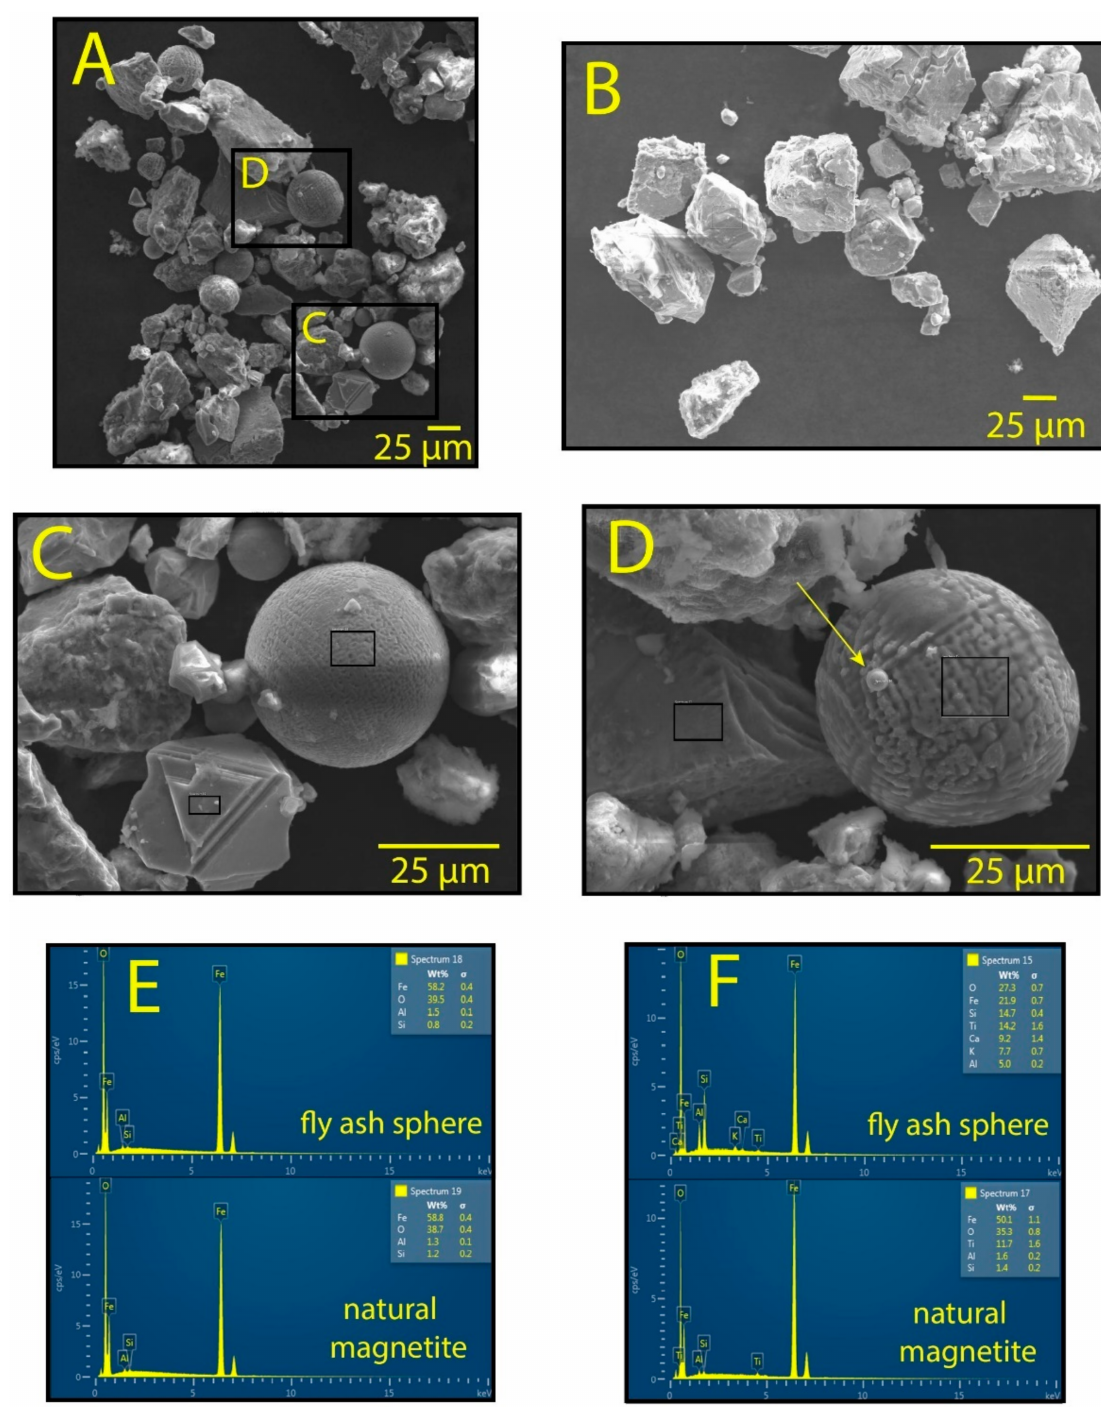
Figure 5. Scanning electron microscope images and energy dispersive X-ray spectroscopy (EDS): ( A ) Multiple fly ash and natural magnetic grains from site NCFA-8, 0–10 cm depth, 150 × magnification; ( B ) Natural magnetic grains from site NCFA-2, 100–120 cm depth (pre-settlement), 300 × magnification; ( C ) Close-up of fly ash sphere and natural magnetite octahedron from NCFA-8, 0–10 cm depth, 1200 × magnification; ( D ) Close-up of fly ash sphere and natural magnetite grain from NCFA-8, 0–10 cm depth, 1500 × magnification, yellow arrow points to small 3 µ m fly ash particle; ( E ) Elemental spectrum of a magnetic fly ash (likely magnetite or maghemite) and natural magnetite particle (black rectangles in [ C ] show area of EDS); ( F ) Elemental spectrum of a magnetic fly ash and natural magnetite particle (black rectangles in [ D ] show area of